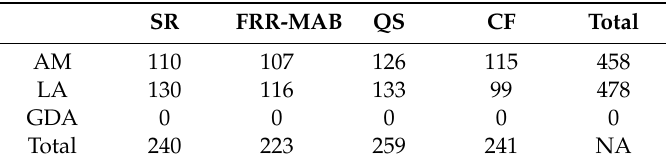
Table 5. Scores of each HLH strategy.